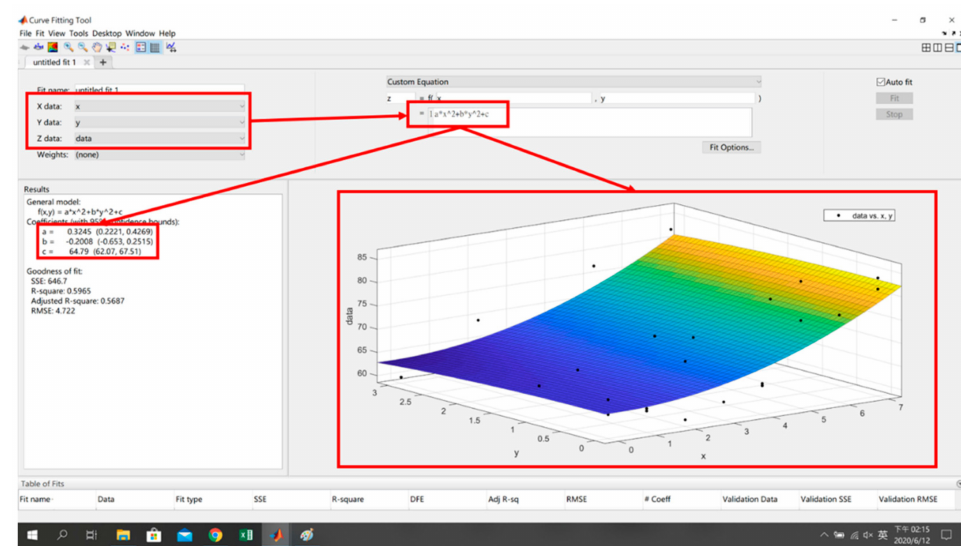
Figure 11. Fitting Model and Equation Generation.